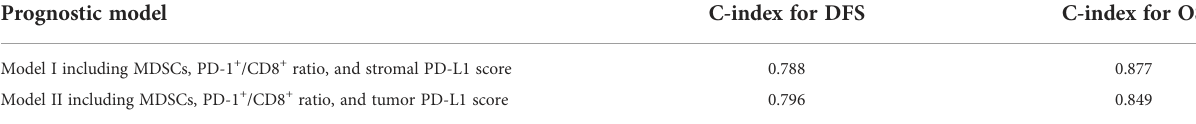
TABLE 3 Prognostic strength of the two models integrating the levels of MDSCs and PD-1/PD-L1 axis. Prognostic